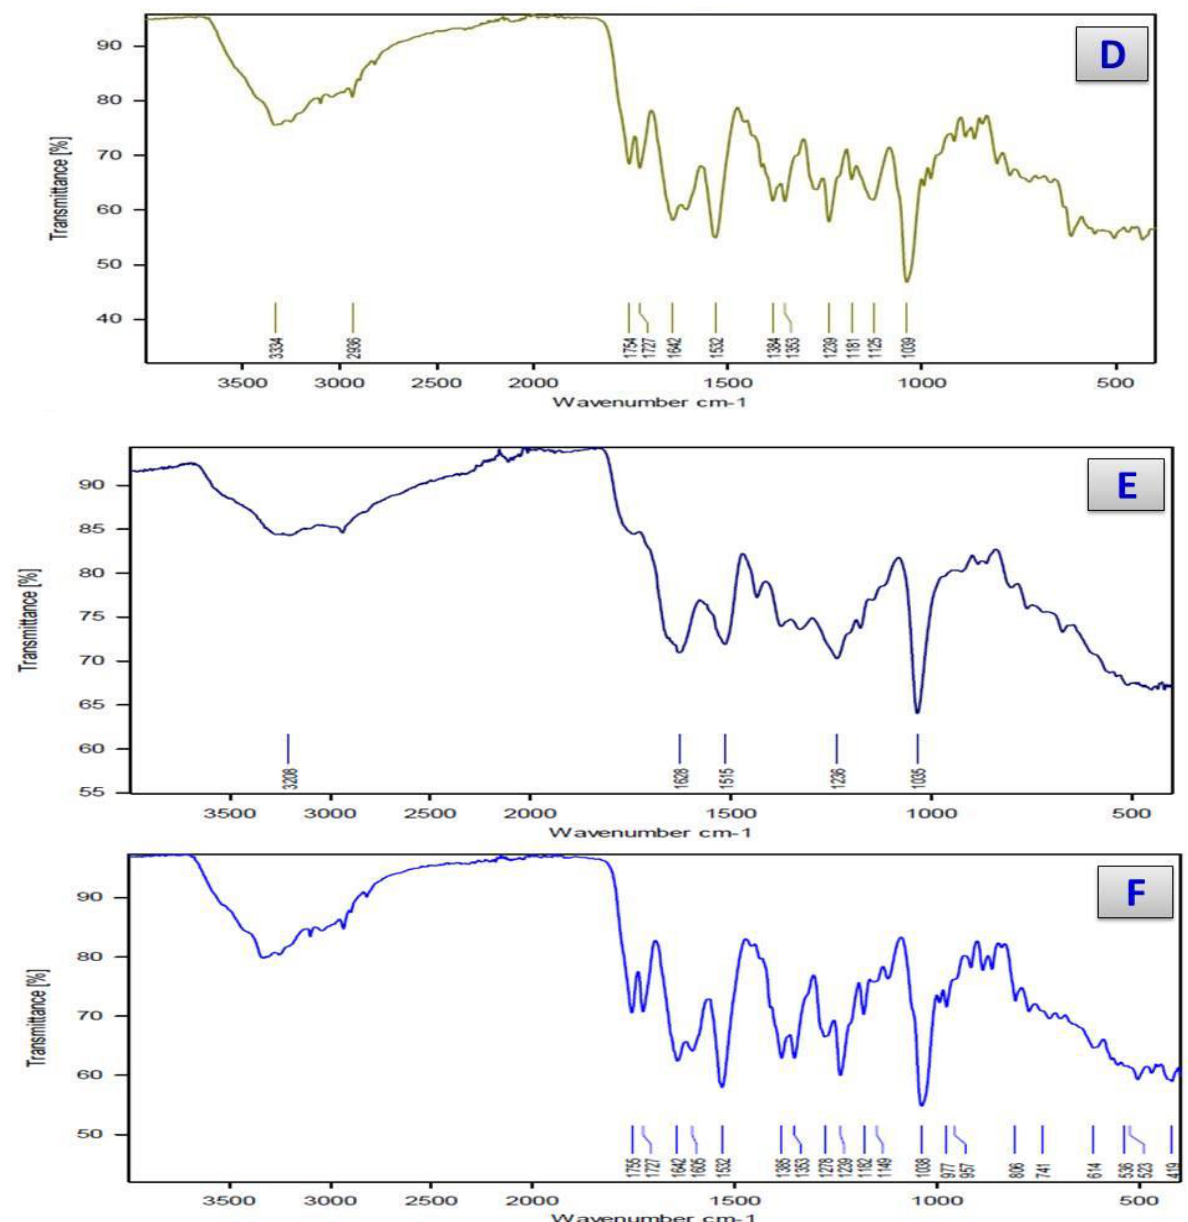
Figure 2. Infrared spectra of ( A ) Cfotax, ( B ) cefotax/Ca, ( C ) cefotax/Cu, ( D ) cefotax/Cr, ( E ) cefo- tax/Zn, and ( F ) cefotax/Se.